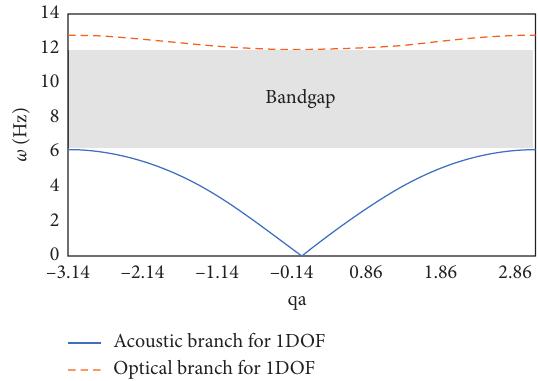
Figure 3: Dispersion curves for the 1DOF